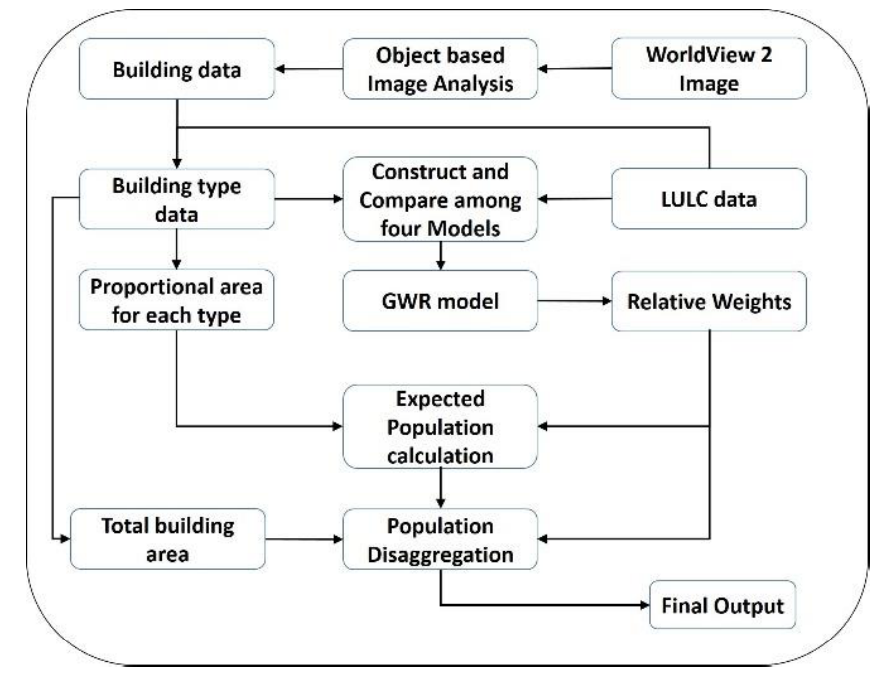
Figure 2. A framework of the research.